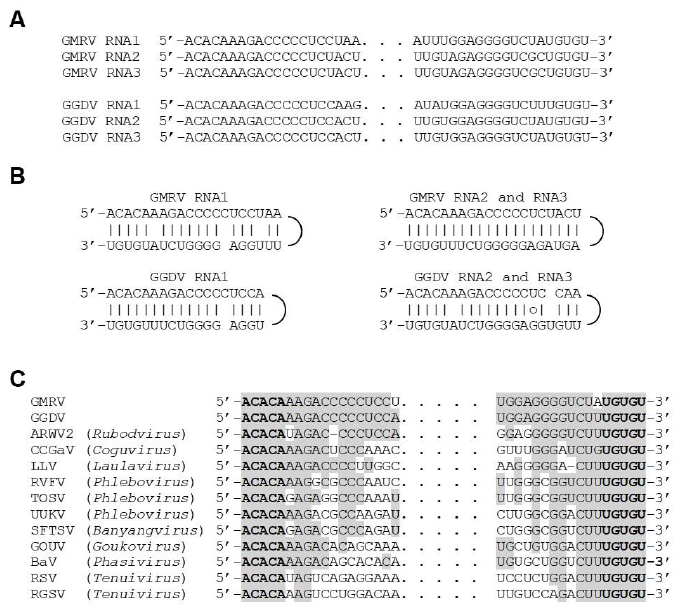
Figure 2. Terminal sequences of grapevine Muscat rose virus (GMRV) and grapevine Garan dmak virus (GGDV). ( A ) Alignment of 5 (cid:48) (left) and 3 (cid:48) (right) termini of GMRV and GGDV RNAs. ( B ) Prediction of panhandle structures formed by the 5 (cid:48) and 3 (cid:48) termini of GMRV and GGDV RNAs. ( C ) Alignment of GMRV and GGDV RNA 1 termini with those of other negative-stranded RNA viruses. Identical nucleotides are in grey. ARWV2, apple rubbery wood virus 2; BaV, Badu phasivirus; CCGaV, citrus concave gum-associated virus; GOUV, Gouleako virus; LLV, Laurel Lake virus; RGSV, rice grassy stunt virus; RSV, rice stripe virus; RVFV, Rift Valley fever virus; SFTSV, severe fever with thrombocytopenia syndrome; TOSV, Toscana virus; UUKV, Uukuniemi